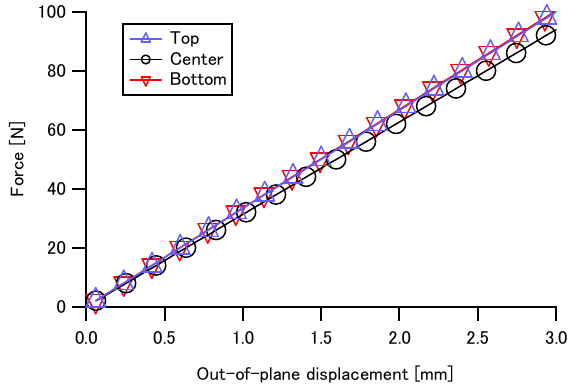
Figure 13. Effect of loading position on out-of-plane